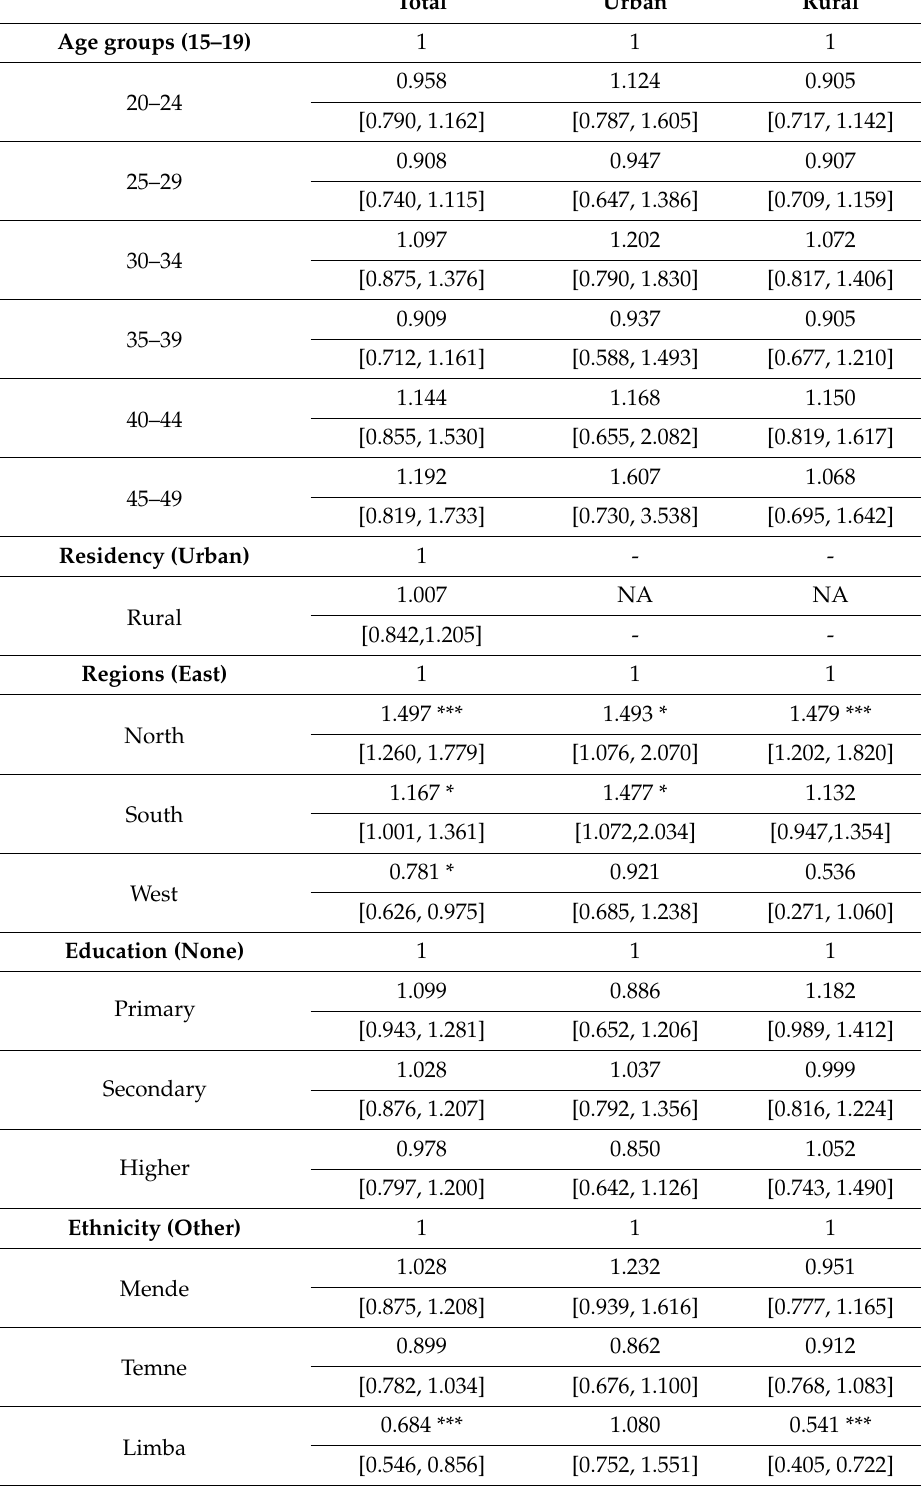
Table 3. Predictors of taking adequate doses of IPTp-SP among urban and rural women in Sierra Leone (multivariate